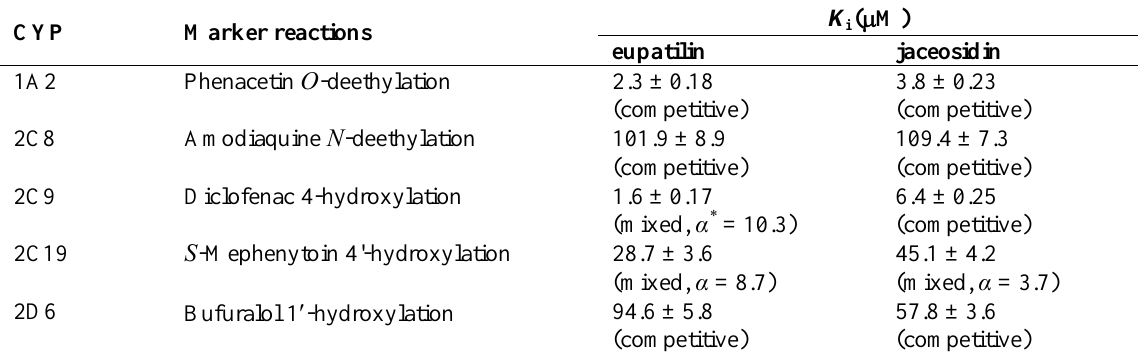
Table 2. K values for the inhibition of CYP1A2, CYP2C8, CYP2C9, CYP2C19, and i CYP2D6 activities by eupatilin and jaceosidin in pooled human liver